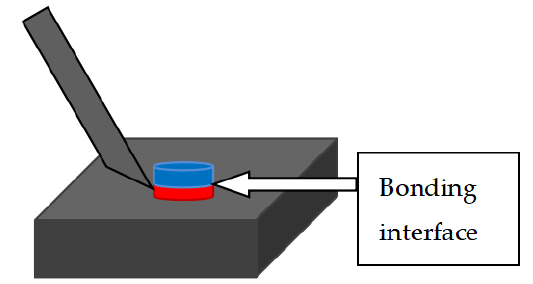
Figure 12. Schematic diagram of the pushing of the ball.